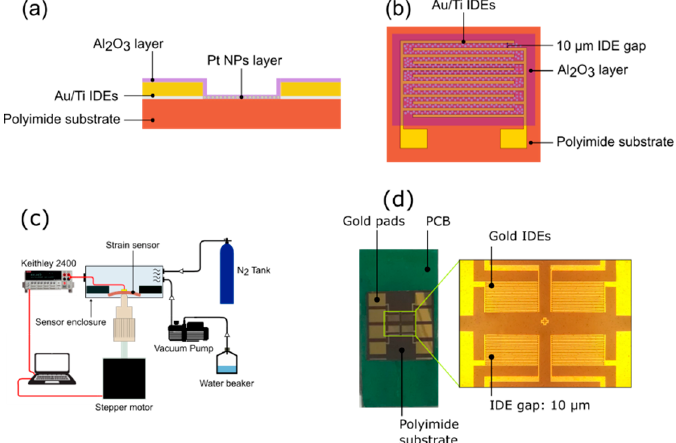
Figure 1. ( a ) Schematic cross section of the sensor ( b ) top down view of the sensor ( c ) Schematic of the experimental setup. ( d ) Image of the strain sensors on a PCB. There are 4 identical strain sensors in each device.